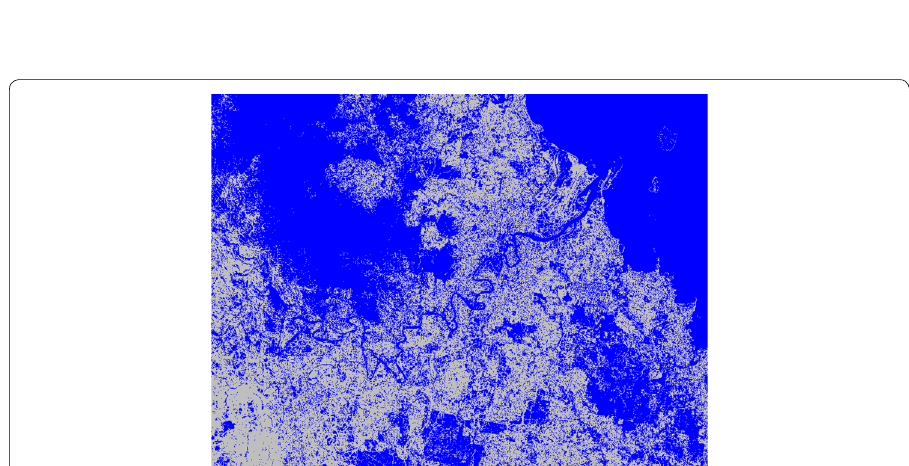
Fig. 11 Tree diagram for the image shown in Fig. 8. The number in each bubble indicates the percentage of pixels contained in the corresponding